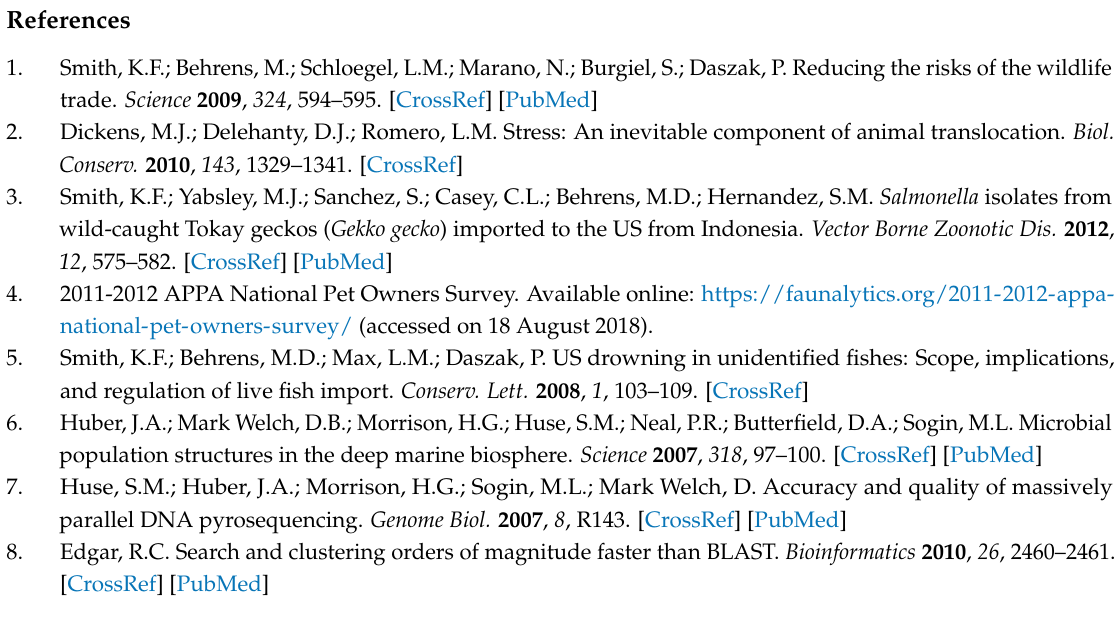
Table S1: Description of 454-specific adaptor sequences, and our universal bacteria V6–V4 16S rRNA gene primer sequences used to generate sequenced amplicons (see vamps.mbl.edu), Table S2: MIMARKS-compliant table of sample associated meta-data. Table S3: Excel file depicting the relative percentage of a given taxonomic group to species level within each sample. Data are available for visualization using the tools available at http://vamps.mbl.edu and logging in as guest. Figure S1: Legend to accompany Figure 1 summarizing the taxonomic composition for each sample. OTU tables were generated using a hybrid USEARCH [8], GAST [9] pipeline, and graphics were generated in Qiime v 1.2.0